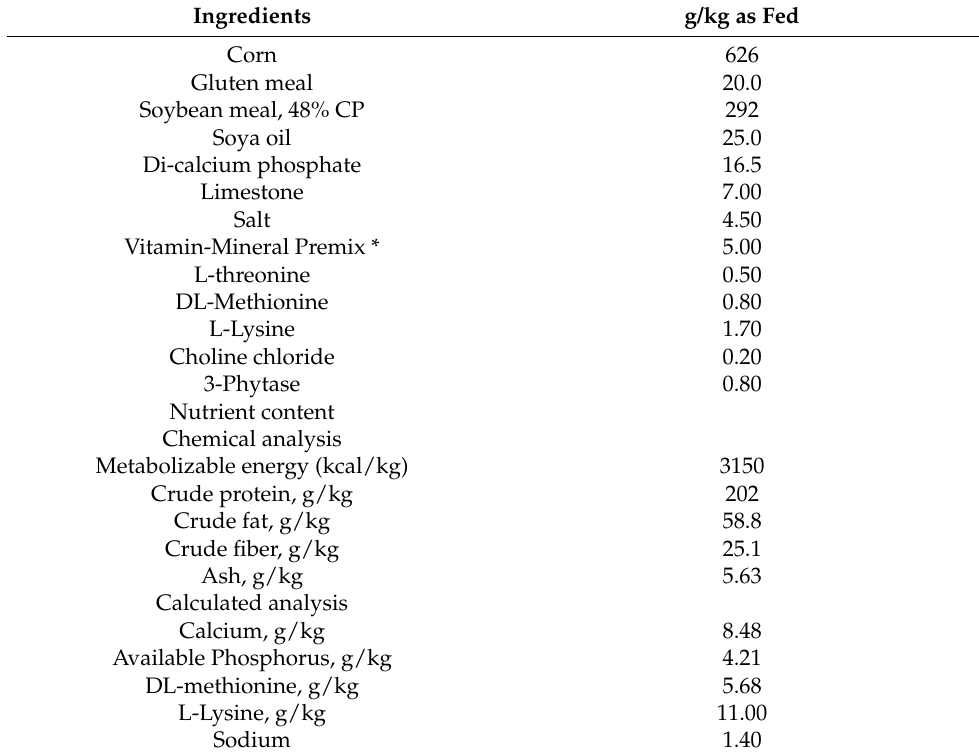
Table 1. Basal diet ingredients and nutrient content fed to broiler chickens from day 22 to 42 of age.